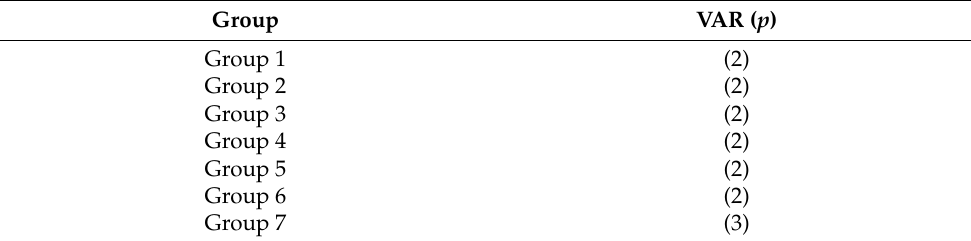
Table 3. Results of VAR model selection for each